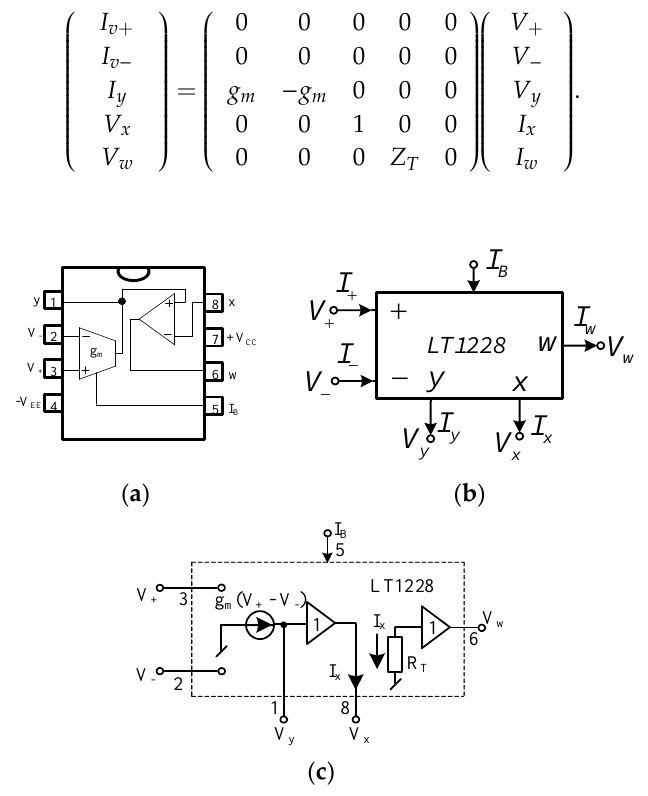
Figure 3. LT1228. ( a ) Pin; ( b) Symbol; ( c ) Equivalent circuit.